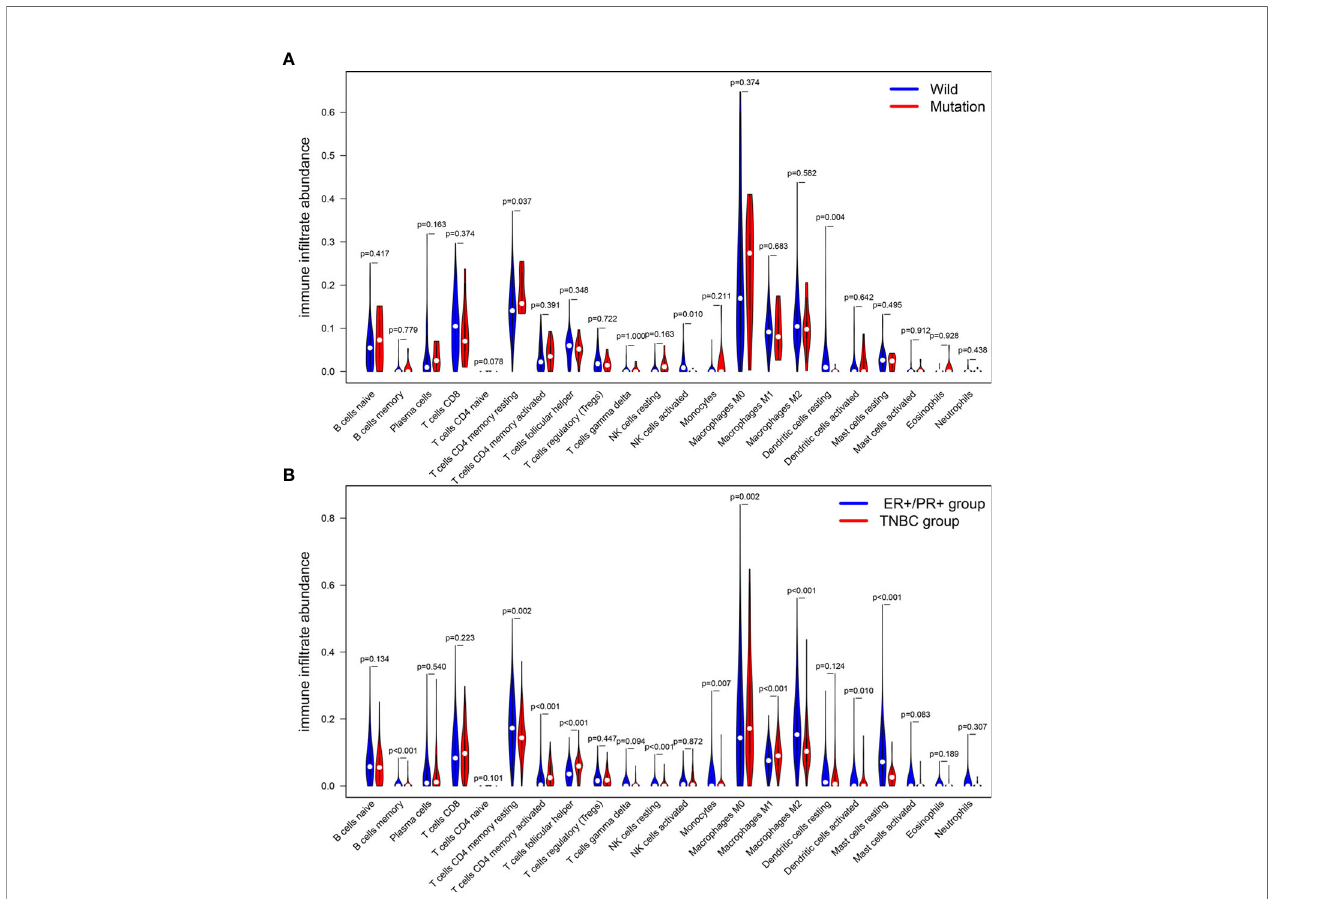
FIGURE 3 | Analysis of the difference of immune cells in fi ltration abundance. (A) between FAT3 mutant group and wild group. (B) ER+/PR+ groups and TNBC groups. Blue represents the wild group and red represents the mutant group. The difference was statistically signi fi cant (P <